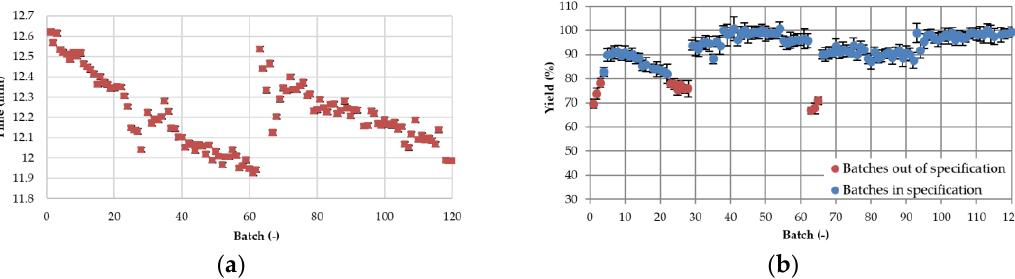
Figure 13. ( a ) Mean residence time of side component 2 from 10 to 15 min and ( b ) yield of the 120 runs.